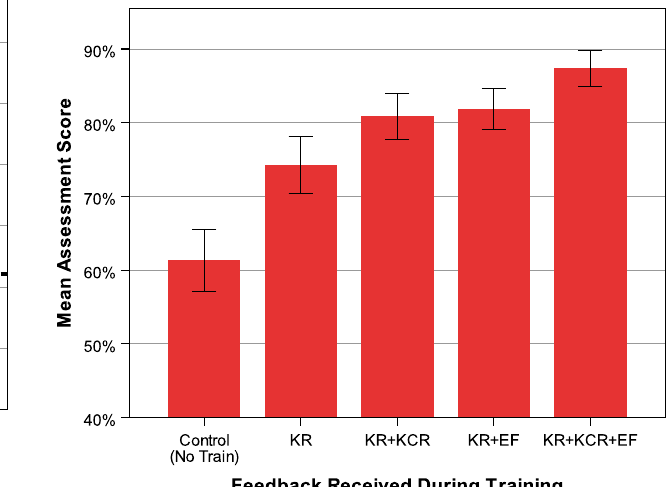
FIG. 5. Mean assessment scores for experiment 1 feedback conditions, split by high and low scores on the first six training questions. The dotted line represents the mean control score.